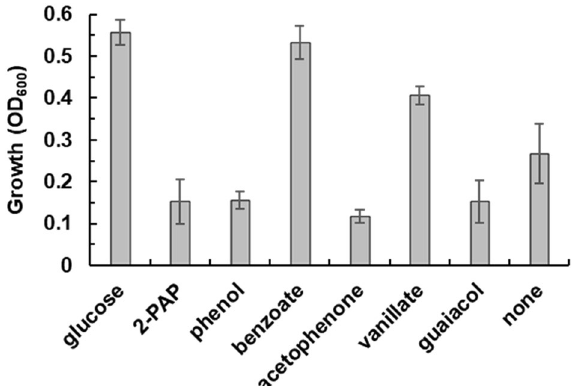
Figure 5. Growth of strain TUS-SO1 on different carbon sources. Strain TUS-SO1 was cultivated for 48 h in basal liquid medium supplemented with each indicated carbon source (1 mM) and yeast extract (0.5 g/L). The OD 600 value at the time of inoculation was 0.03. Data are the average of five independent experiments, and error bars indicate the standard deviation from the